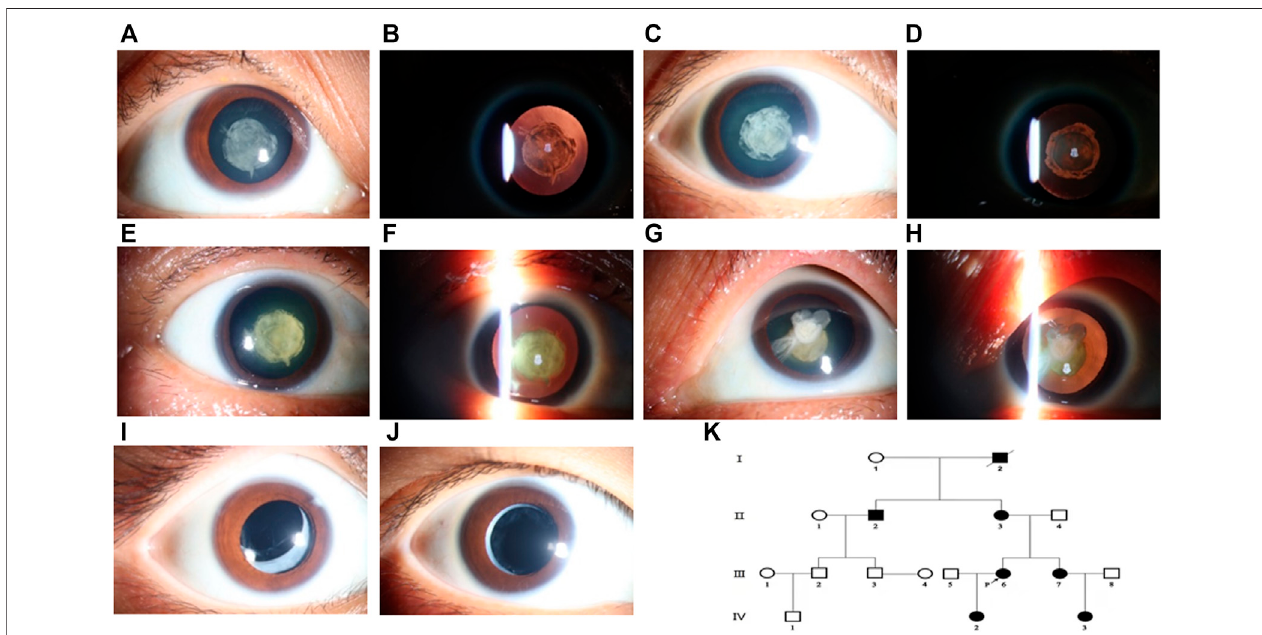
FIGURE 1 | Cataract features and pedigree of the proband and her family members. The phenotype of the proband (III-5) was documented by ophthalmic operating microscope photography and showed a nuclear cataract in diffuse illumination (A) and retro-illumination (B) . Nuclear opaci fi cation (C , D) was noted for her youngersister (III-7). Thesameshape ofopaci fi cation wasnoted inthe both eyesofher mother (II-3), and both nuclear and cortical cataracts werepresented (E – H) . Her daughter (IV-2) and niece (IV-3) also had congenital cataract and received surgery treatment with arti fi cial intraocular lens (I , J) . Pedigree of the Chinese family with autosomal dominant congenital cataract in four generations (K) . Squares and circles represent males and females, respectively. Filled symbols indicate affected members and empty symbols indicate unaffected individuals. The diagonal line indicates a deceased family member, and the arrow indicates the